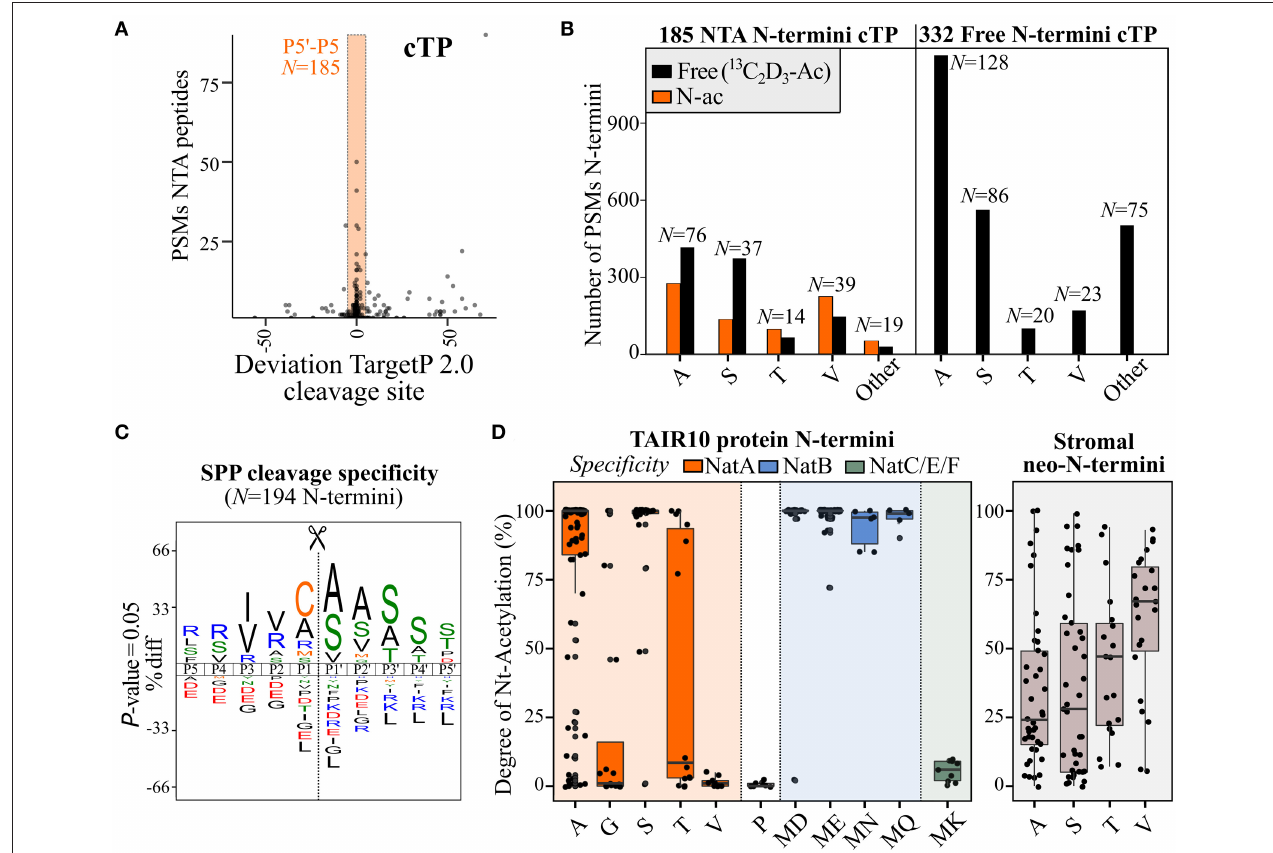
FIGURE 4 | Differences in N-terminal acetylation patterns of N-terminal proteoforms arising from stromal processing peptidase (SPP) processing or (alternative) translation initiation. (A) PSMs of NTA peptides identified in cell cultures in function of the deviation to the chloroplast transit peptide (cTP) P1 ′ cleavage site predicted by TargetP 2.0 ( Almagro Armenteros et al., 2019). The orange rectangle reflects the P5–P5 ′ predicted region, considered in this study to assign neo-N-termini indicative of cTP cleavage. (B) Number of identified PSMs of identified NTA [and corresponding Nt-free ( 13 C 2 D 3 -Ac), if any] Nt peptides matching considered cTP cleavages [see panel (A) ] in the case of N-termini exclusively identified as Nt-free (right) or identified by at least one PSM as NTA (left). Only Ala, Ser, Thr, and Val neo-N-termini (number indicated above bar) were plotted, as these represent the majority of cTP cleavage neo-N-termini (3,739/4,322 PSMs, 87%). (C) iceLogo (Colaert et al., 2009) motifs of cleavage motifs (P5–P5 ′ ) with an Nt peptide start position deviating maximally five residues of the predicted chloroplast or mitochondrial transit peptide (cTP/mTP) cleavage site ( Almagro Armenteros et al., 2019) and with a SUBA4 chloroplast consensus location (Hooper et al., 2017). In case multiple cleavage sites were identified within a 5-residue window, the most upstream neo-N-terminus was selected as representative member. (D) Degree of NTA (%) for annotated protein N-termini (left) and stromal neo-N-termini (right) was plotted for various types of N-termini according to their NAT specificity profiles. N-termini matching NatA, NatB, or NatC/E/F specificities are indicated in orange, blue, and green, respectively, while stromal protein NTA is indicated in gray. Only Nt residue(s) with at least five data points were plotted; for full overview (see Supplementary Dataset S4